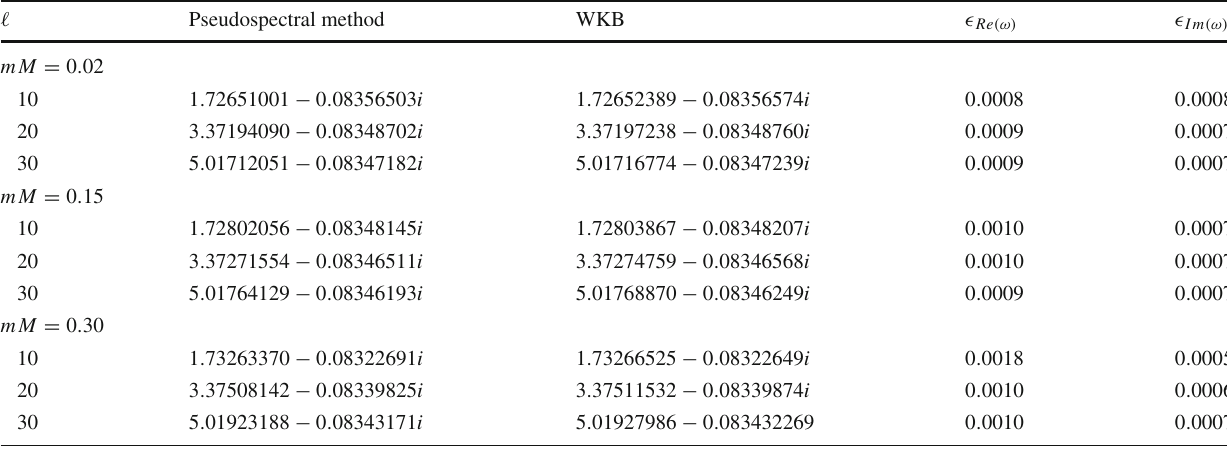
Table 1 Fundamental quasinormal frequencies ( n PS = 0) for massive scalar fields with (cid:5) = 10 , 20 , and 30 in the background of black hole solution of f ( R ) gravity with M 2 (cid:6) = 0 . 04, and M β = 0 . 01